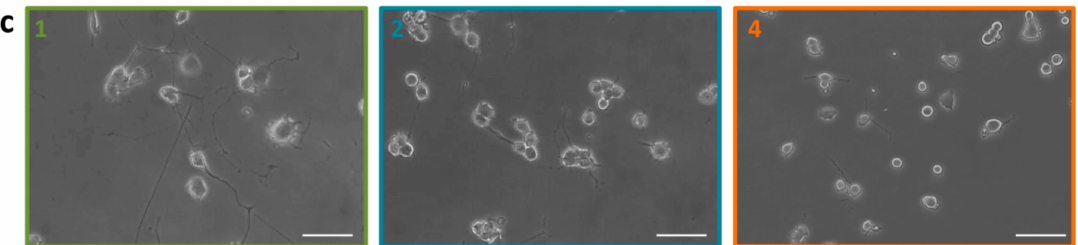
Figure 5. ( a ) Schematic illustration of cell culture dish with magnet location. Areas 1, 2, 3, and 4 indicate sites of imaging; ( b ) Confocal fluorescent images of PC12 cells at different locations relative to magnet, as marked in A; ( c ) Phase contrast images of differentiated PC12 cells at different locations relative to magnet, as marked in A. Scale bar = 50 µ m.